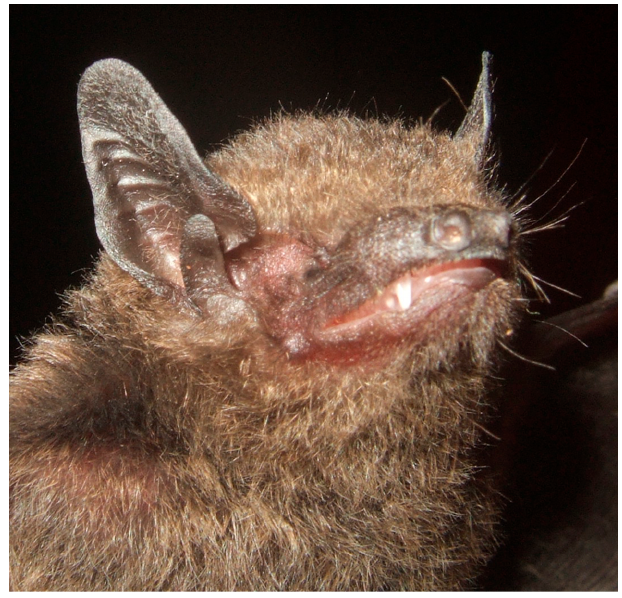
Figure 23. Pipistrellus abramus , adult male. Photograph by Vu Dinh Thong.